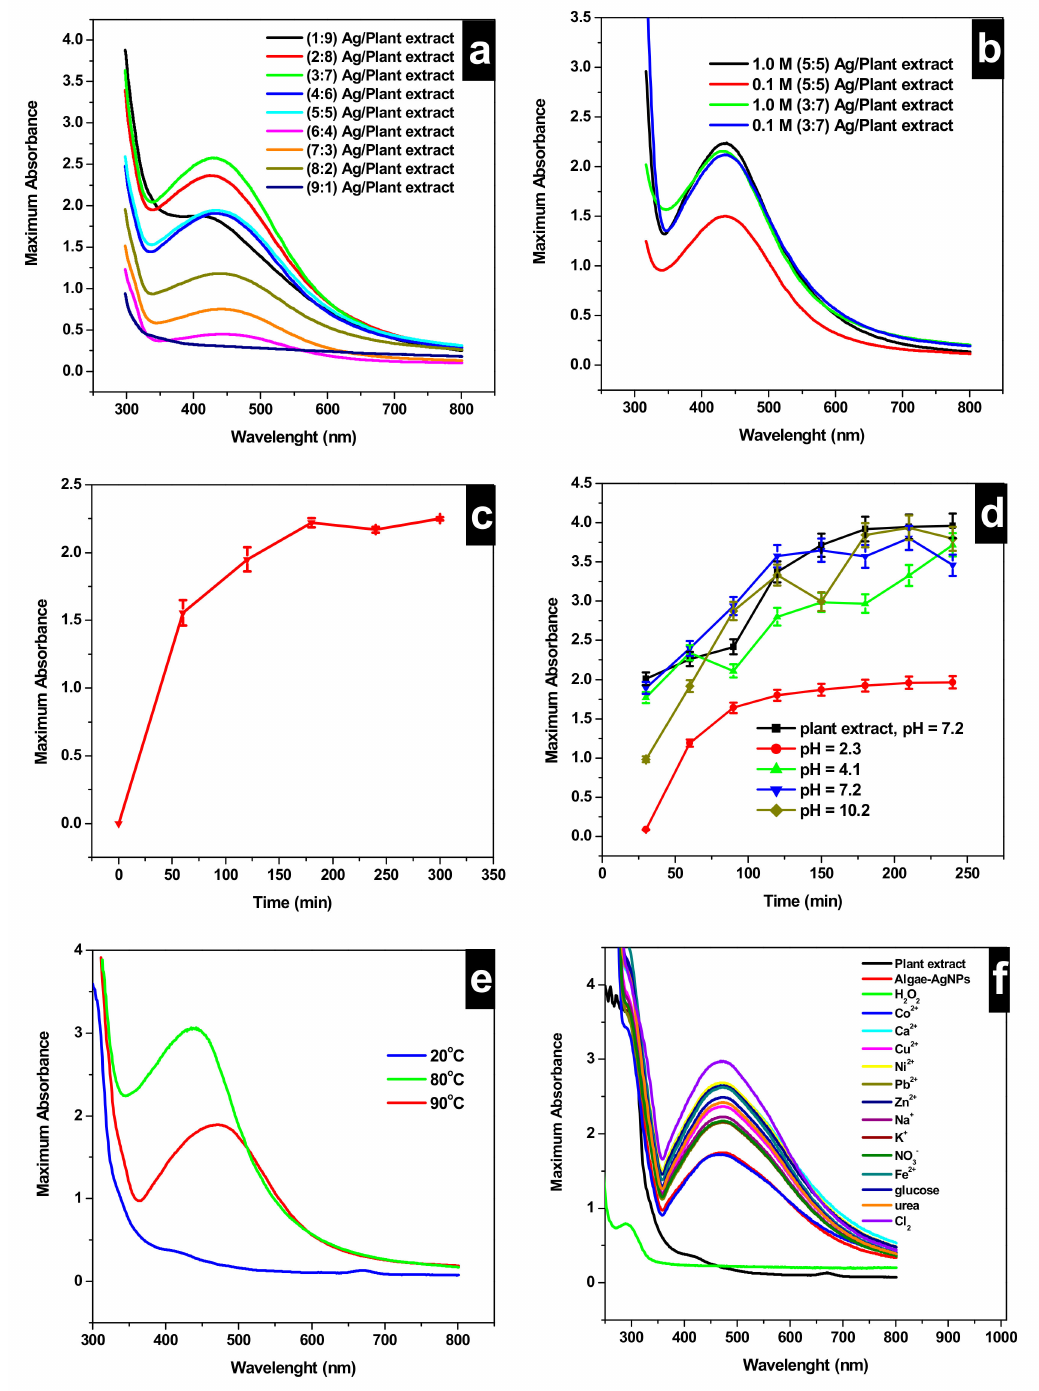
Figure 3. Localized surface plasmon resonance (LSPR) absorbances of Algae-AgNPs; ( a ) as a function of AgNO 3 / plant extract ratios ranging from 1:9 to 9:1 v / v , ( b ) as a function of AgNO 3 / plant extract ratios and AgNO 3 molar concentration; ( c ) time e ff ect on the formation of Algae-AgNPs at 80 ◦ C, 0.1 M AgNO 3 , and 3:7 v / v AgNO3 / plant extract ratio, pH 0 = 7.0; ( d ) pH e ff ect on the formation of Algae-AgNPs at 80 ◦ C, 0.1 M AgNO 3 , and 3:7 v / v AgNO3 / plant extract ratio; equilibrium time varies from 30 to 240 min; ( e ) Temperature e ff ect on the formation of Algae-AgNPs at 25, 80, and 90 ◦ C; 0.1 M AgNO 3 and 3:7 v / v AgNO3 / plant extract ratio; equilibrium time = 150 min; pH 0 = 7.0; ( f ) reacted with cation, anion, and neutral species; equilibrium time = 3.0 min; pH 0 = 7.0, T = 25 ◦